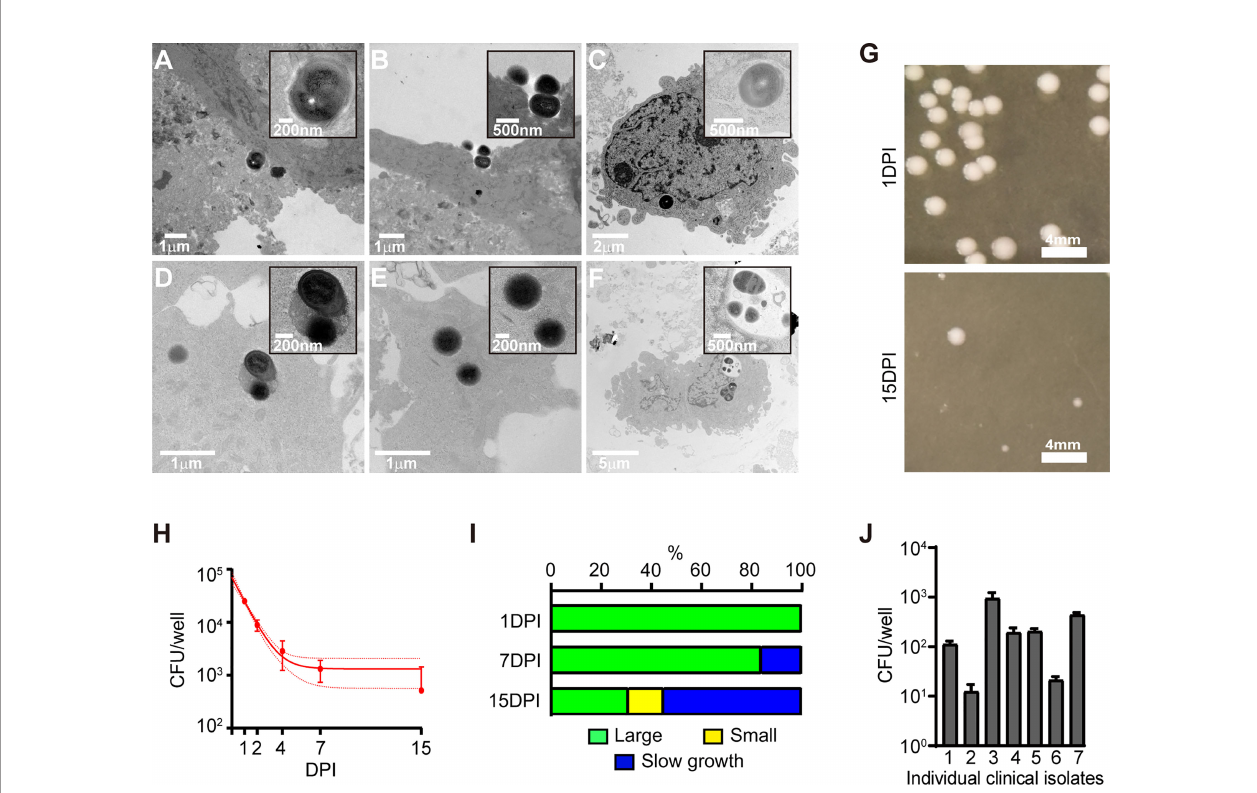
FIGURE 2 | Characterisation of the intracellular infection of SaOS2-OY. (A – F) Transmission electron microscopy images of SaOS2-OY either following 2h (A, B) or 24h (C – F) of exposure to WCH-SK2. (G) Representative images of colonies grown after 24h of plate incubation from the infection presented in (H) . (H) Infection dynamics of WCH-SK2 within the lysate of SaOS2-OY cultured within lysostaphin enriched media. Data shown are means ± 95% con fi dence intervals. (I) Distribution of colony morphology classi fi cations across the duration of the infection presented in H. (J) Bacterial burden measured after 24h of intracellular infection with a range of S. aureus clinical osteomyelitis isolates, all assayed at a con fi rmed MOI of 0.5. DPI, Days post-infection; CFU, Colony forming